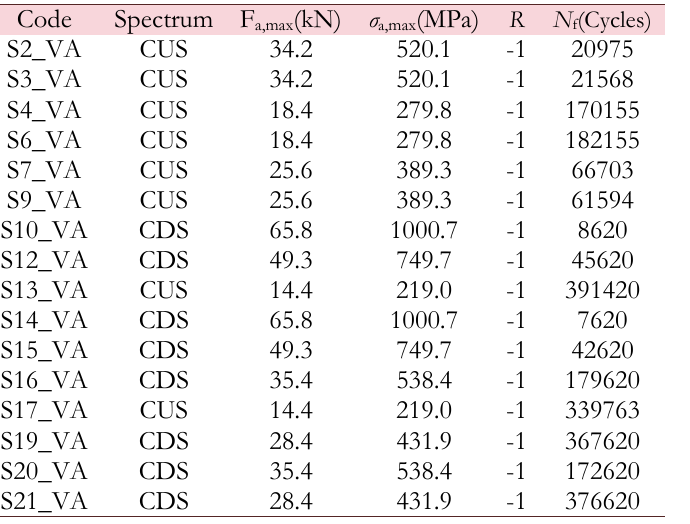
Table 2: Summary of the experimental results generated by testing the notched specimens with root radius equal to 0.225 mm under VA fatigue loading [3].